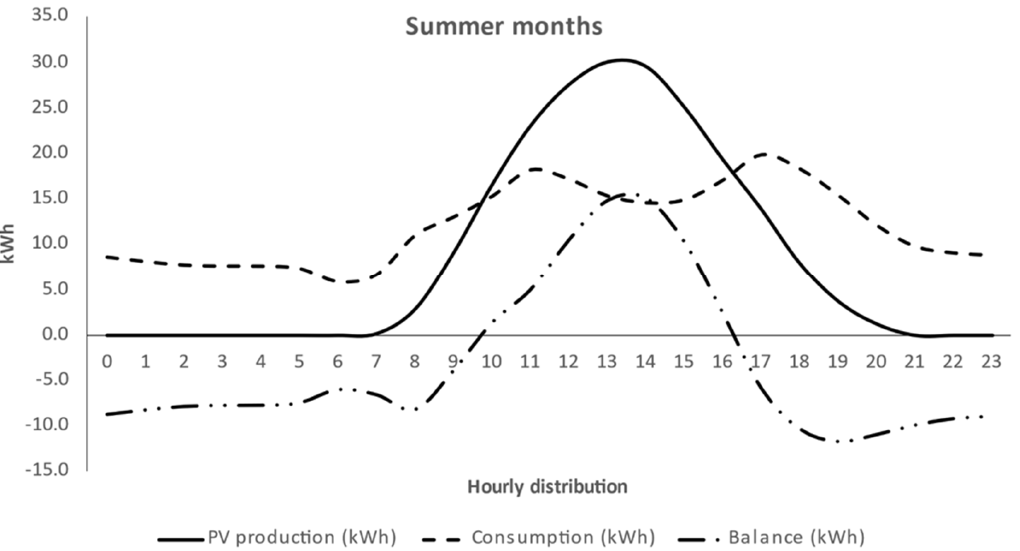
Figure 9. Average hourly distribution of production, consumption, and balance for the summer months (March to October).